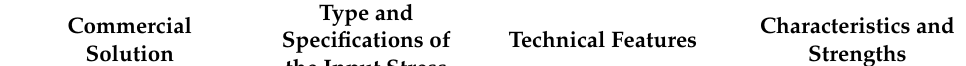
Table 5. Comparison between different commercial solutions for energy harvesting along